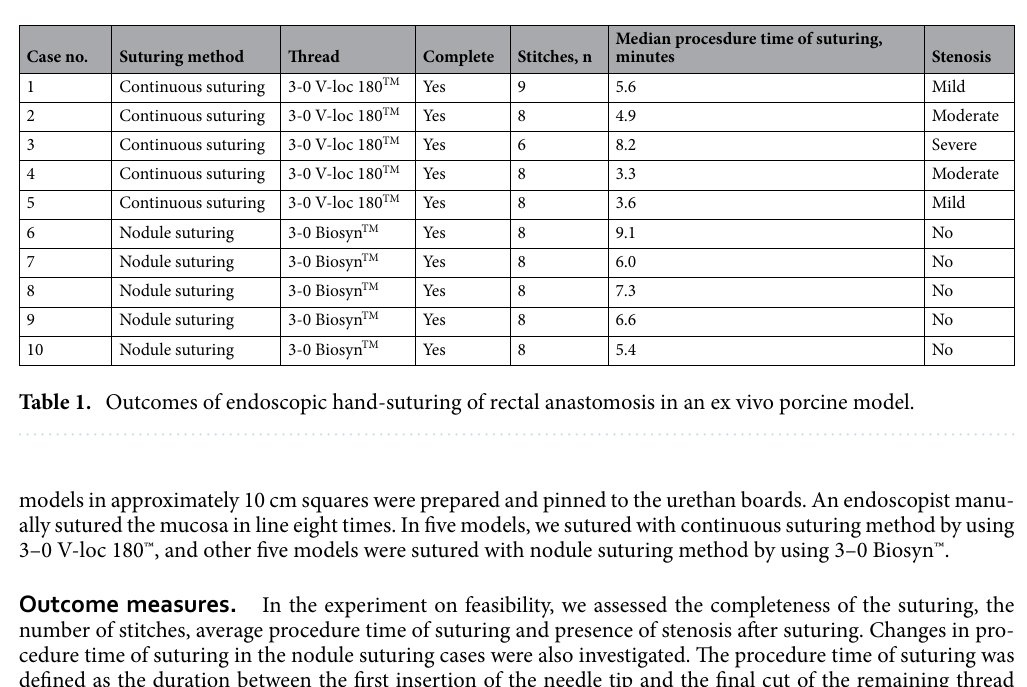
Median procesdure time of suturing, minutes